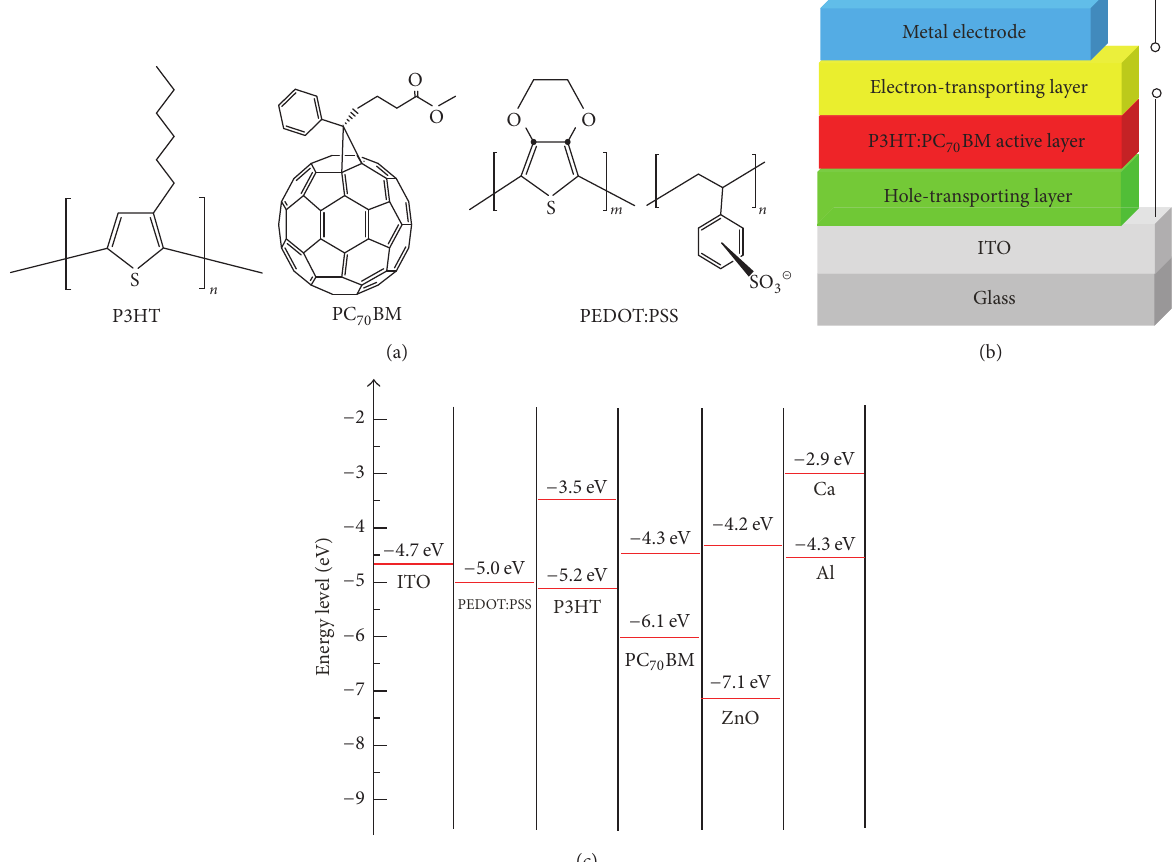
(DCB) solution of P3HT:PC 70 BM (1 : 0.8 by weight)